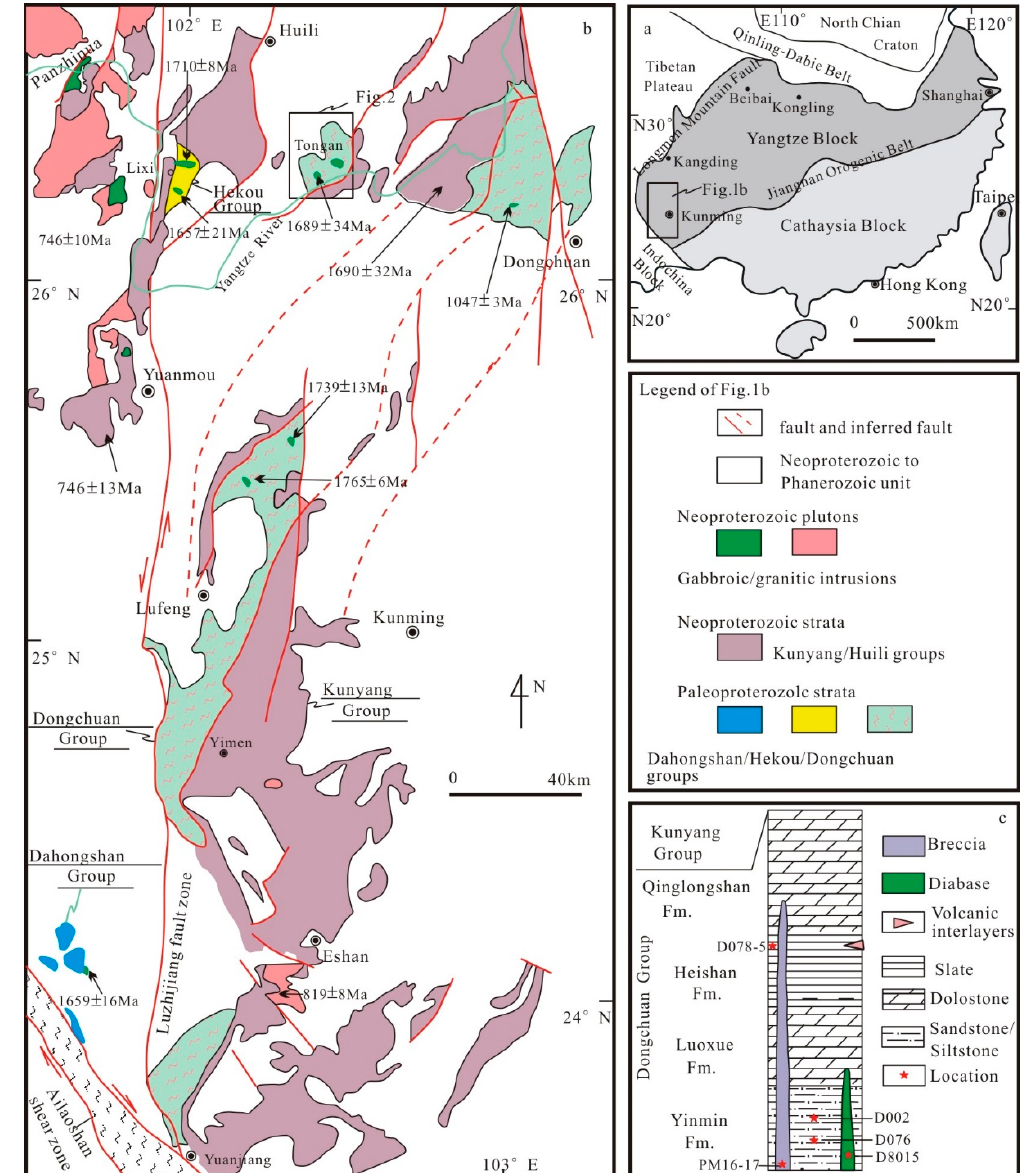
Figure 1. ( a ) Geological sketch map of the tectonic outline; ( b ) a geological map of Precambrian strata and Proterozoic intrusions of the SW Yangtze Block, South China [15,22,28,46]. The zircon U–Pb ages of the Proterozoic intrusions are from the literature [16,18,22,35,40,46,57–59]. The limited distribution of Archean–Paleoproterozoic geologic entities developed in the Yangtze Block is only exposed in the Kongling and Yichang areas on the northern margin of the Yangtze